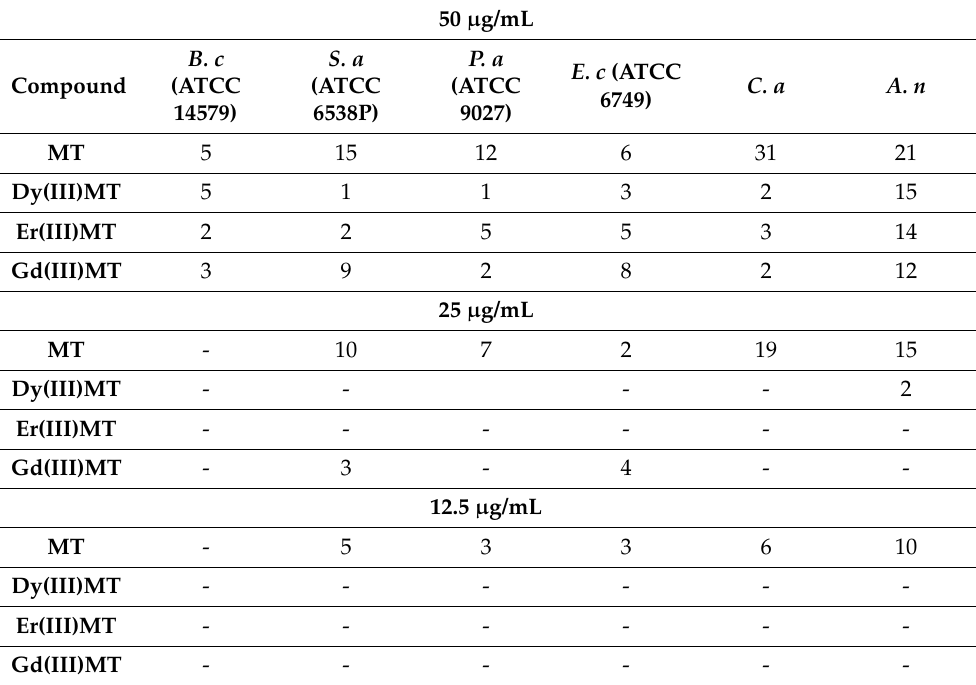
Table 6. Inhibition zone diameter (IZD in mm) of the compounds against typed strains (ATCC CULTURES)